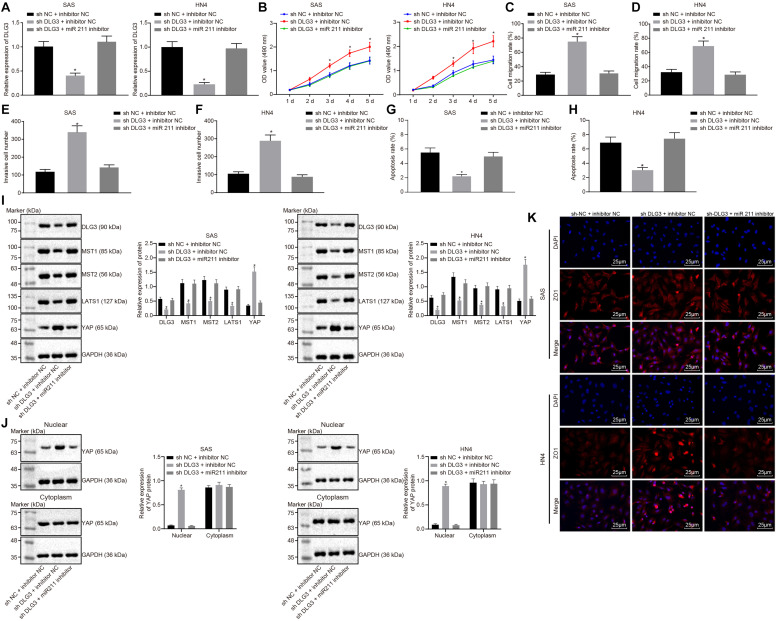
DLG3 silencing promotes the progression of OSCC in vitro via activation of the Hippo pathway. SAS and HN6 cells were transfected with sh-DLG3/sh-NC and miR-211 inhibitor/inhibitor NC. (A) DLG3 levels in SAS and HN6 cells after transfection detected using RT-qPCR; (B) Proliferation of SAS and HN4 cells after transfection measured by MTT assay; (C) Migration of SAS cells after transfection assessed by the scratch test; (D) Migration of HN4 cells after transfection assessed by the scratch test; (E) Invasion of SAS cells after transfection, as measured by the Transwell assay; (F) Invasion of HN4 cells after transfection, as measured by the Transwell assay; (G) SAS cell apoptosis evaluated by flow cytometry; (H) HN4 cell apoptosis evaluated by flow cytometry; (I) Expression of DLG3, MST1, MST2, LATS1 and YAP proteins in SAS cells after transfection measured by western blot analysis; (J) Expression of DLG3, MST1, MST2, LATS1 and YAP proteins in HN4 cells after transfection measured by western blot analysis; (K) Expression of YAP protein in the cytoplasm and nucleus of SAS and HN4 cells after transfection measured by immunofluorescence; *p < 0.05 vs. the sh-NC + inhibitor NC group; the data from two groups were analyzed using one-way ANOVA and the data among multiple groups at different time points were tested using repeated measures ANOVA; the experiment was repeated three times independently.